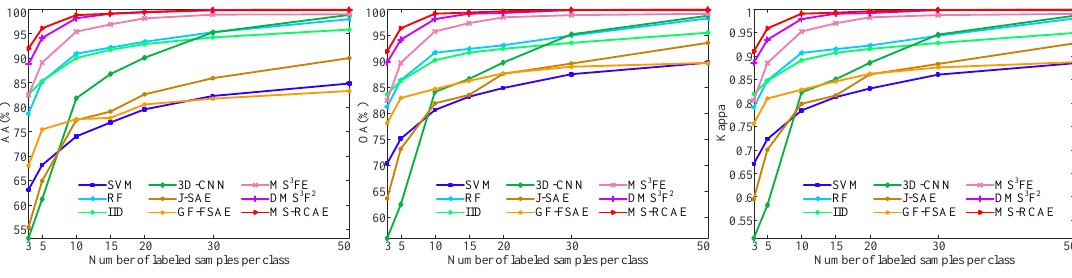
Figure 14. Effect of the number of training samples on classification accuracy for the Salinas dataset.